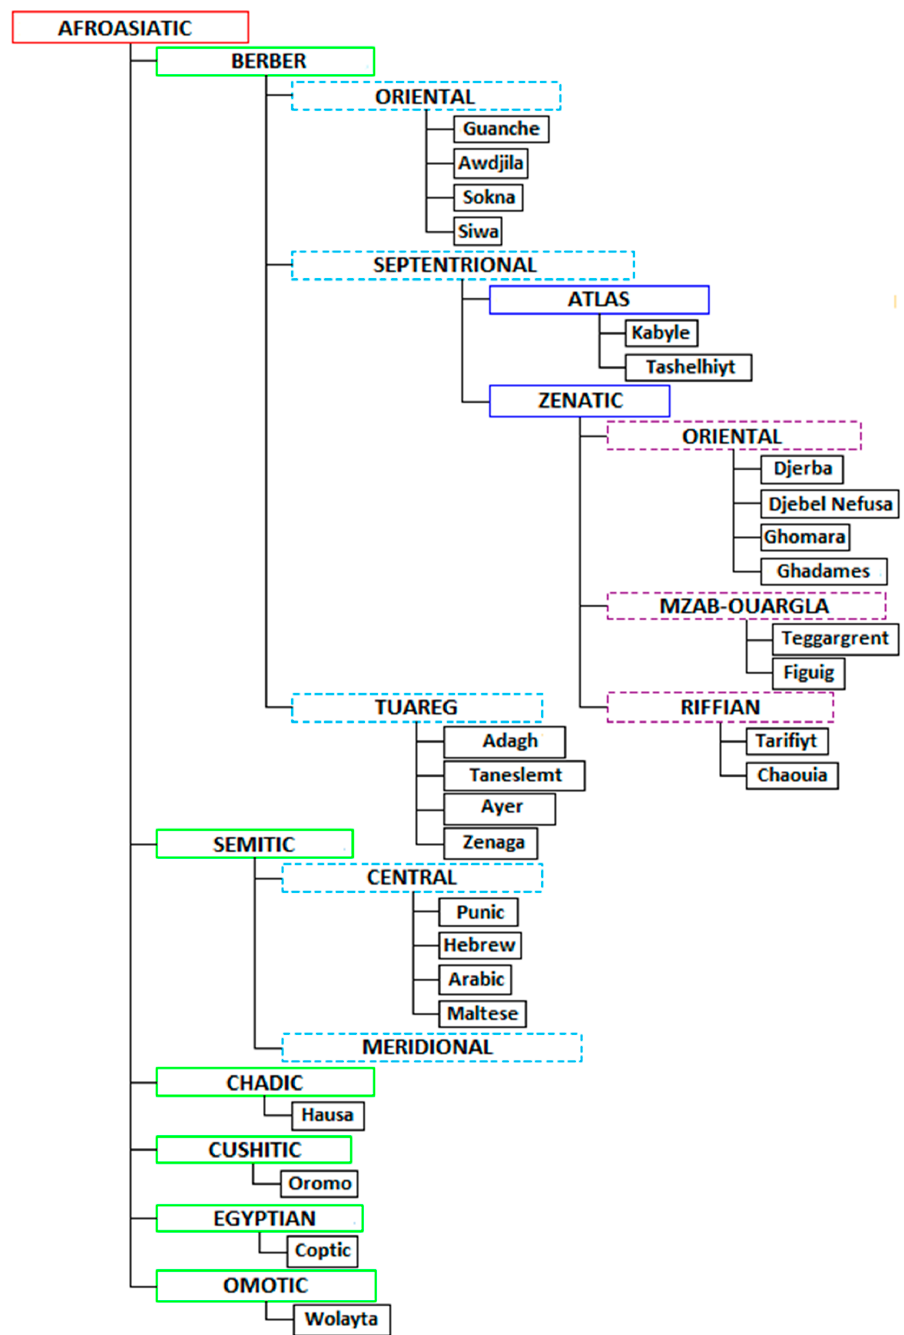
Figure 3. Languages, Subgroups, Groups, Subfamilies and Families of Afroasiatic Phylum (Cabrera 2003; Vera 2016, pp. 322–56).